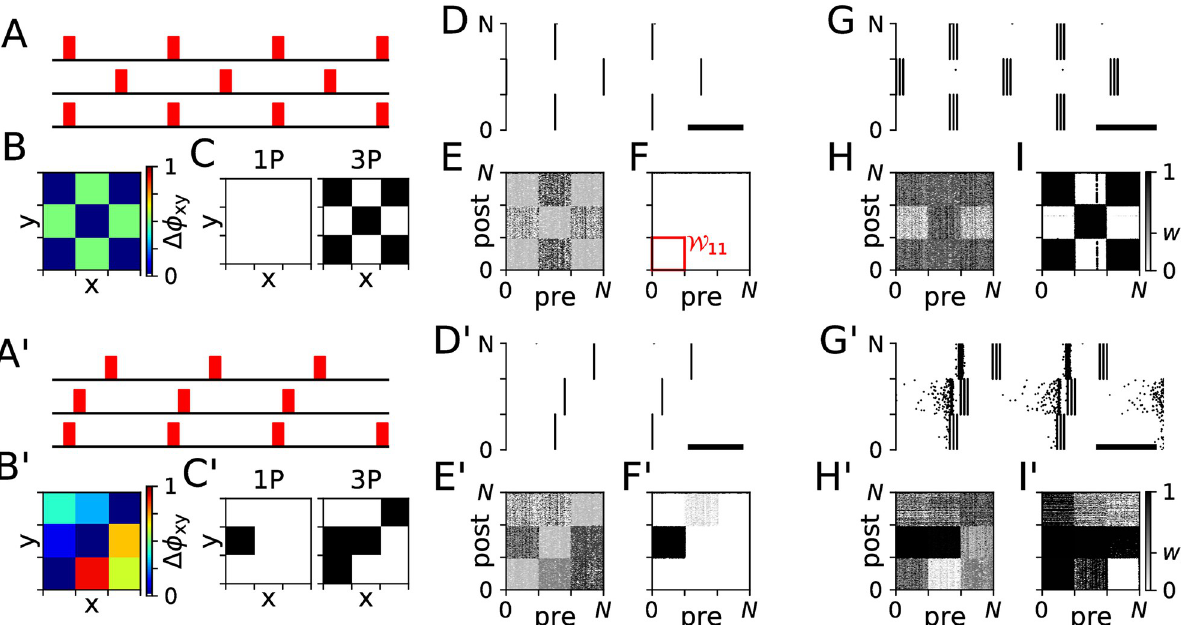
Fig 4. PMCS-induced network structure depends on phase lags and stimulus type. Panels A-I show results for the PMCS pattern illustrated in panel A. Red rectangles mark stimuli. Individual stimuli were either charge-balanced single-pulse (D-F) or burst stimuli (G-I). B: Phase shifts, Δ ϕ xy , between stimulus trains delivered to the postsynaptic subpopulation y and presynaptic subpopulation x . C: lim pulse stimuli (1P) and burst stimuli with three pulses (3P) (see panel I for color code). Panels D-F show a raster plot of simulated spiking activity of the LIF network model 1000 sec after stimulation onset (D), and snapshots of the network’s synaptic weight matrix W taken 20 sec (E) and 1000 sec (F) after stimulation onset. After 1000 sec, acute effects of stimulation have fully developed. The scale bar refers to a 100 ms time interval. The block W the synaptic weight matrix is marked red in panel F. G-I: Same as D-F but for burst stimuli with three pulses per burst and an intraburst frequency of 120 Hz. A’-I’: Same as A-I but for the PMCS pattern illustrated in panel A’. Parameters: f = 5 Hz; A stim = 0.4 (single-pulse stimuli) and 0.8 (burst stimuli), d e = 1. Δ α 1/2 = 0.5 (A-I), and Δ α 1 = 0.1 and Δ α 2 = 0.3 (A’-I’).